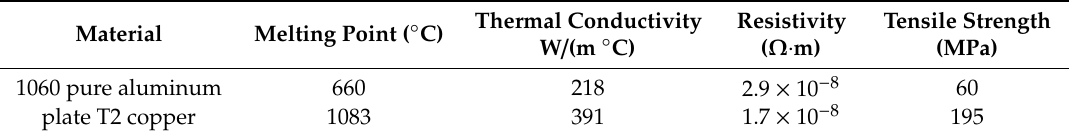
Table 9. Physical and mechanical properties of pure aluminum and T2 copper [18,19].